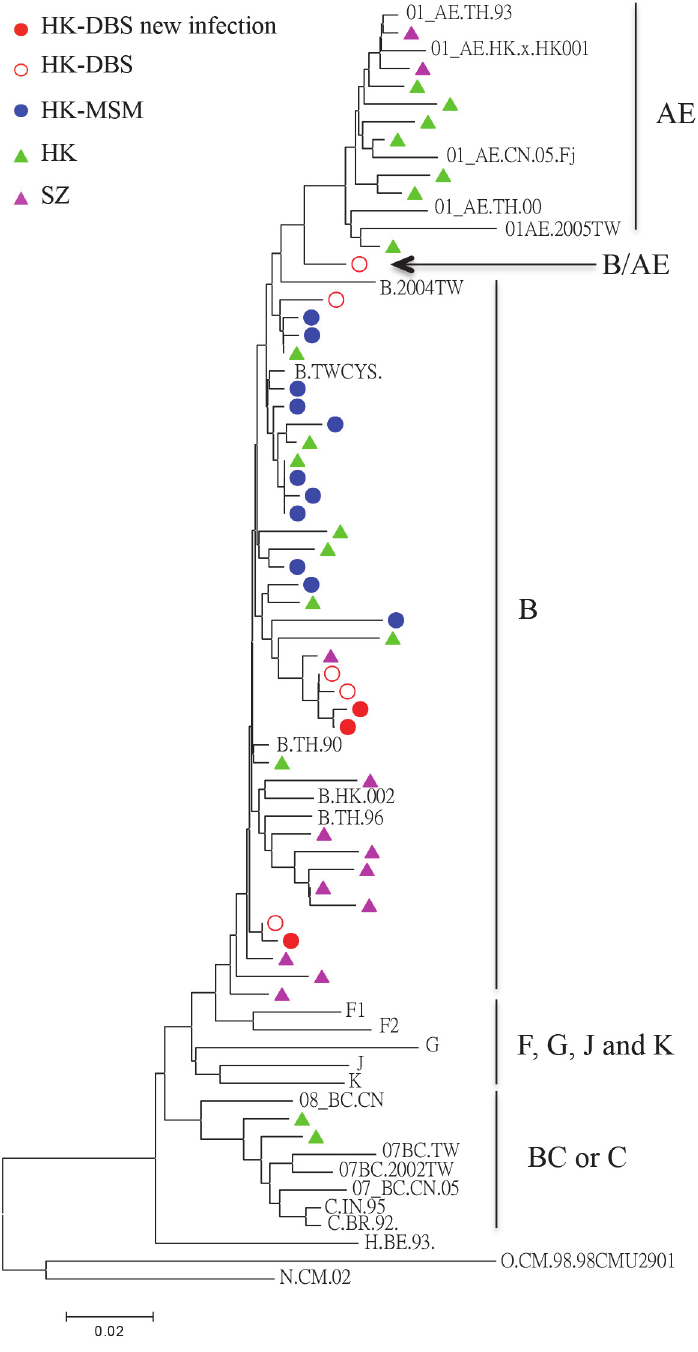
Fig 1. Phylogenetic neighbor-joining tree for HIV-1 pol sequences obtained from DBSs of MSM in Hong Kong. The reference sequences for classifying HIV-1 genotypes were included and were originally obtained from the NIH/NIAID – funded HIV Databases. The source of HIV-1 strains is color-coded. The horizontal branch was drawn in accordance with their relative genetic distances as indicated by the bar scale. The vertical lines are purely for clarity of the tree